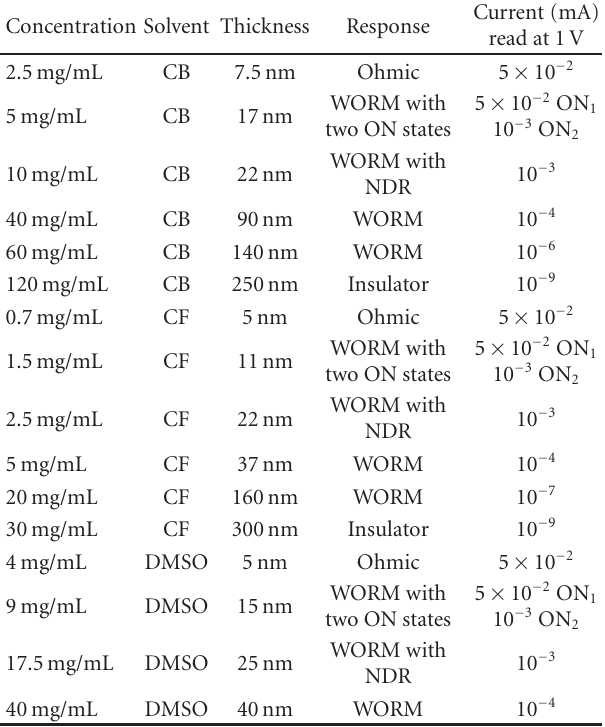
Table 1: Al/PMMA/Al devices fabricated by using di ff erent sol-